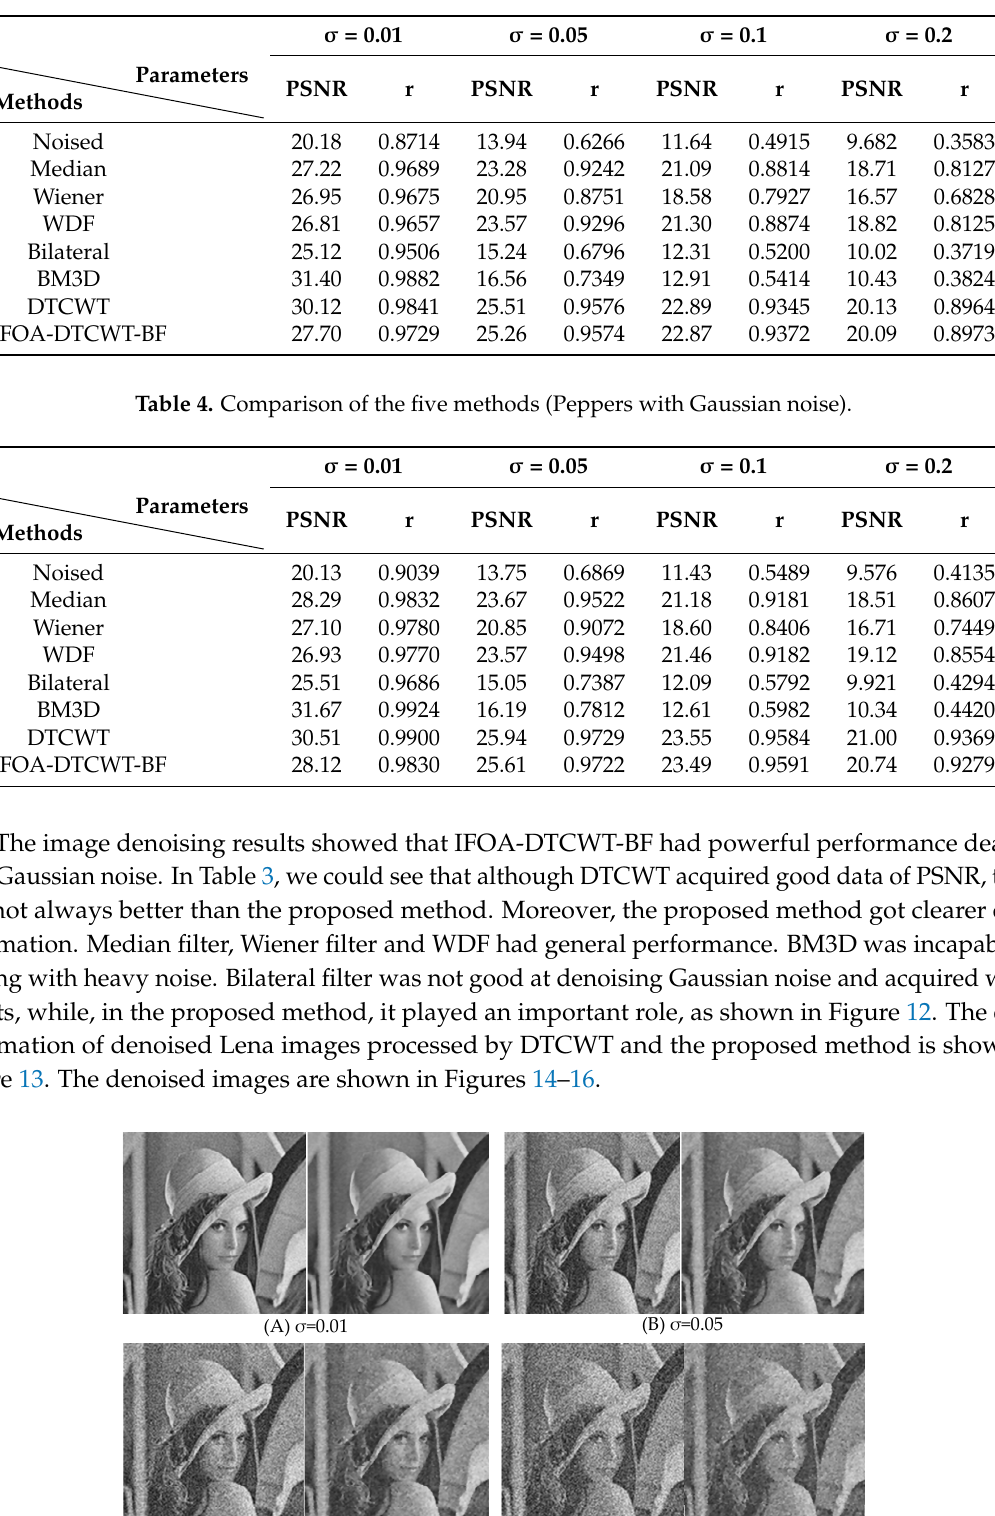
Table 3. Comparison of the five methods (Columbia with Gaussian noise).